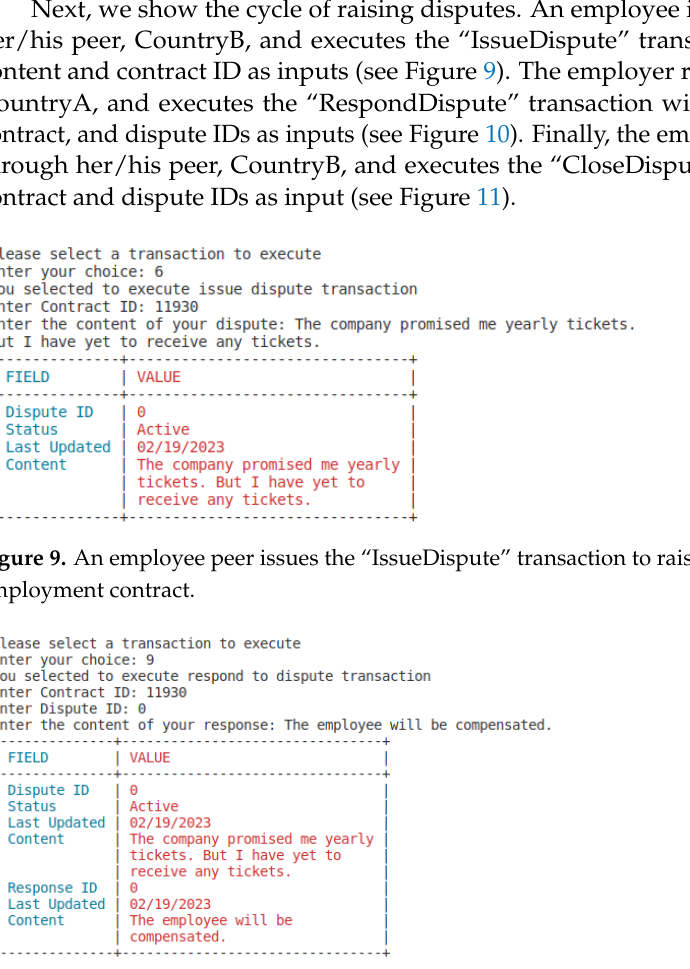
Figure 10. An employer peer issues the “RespondDispute” transaction to reply to a complaint raised by an